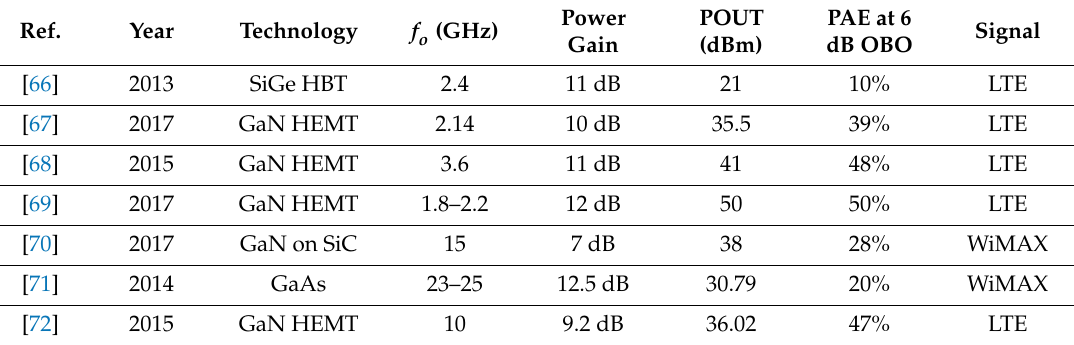
Table 7. Recent research publications for RF and microwave Doherty power amplifiers (PA). Ref.